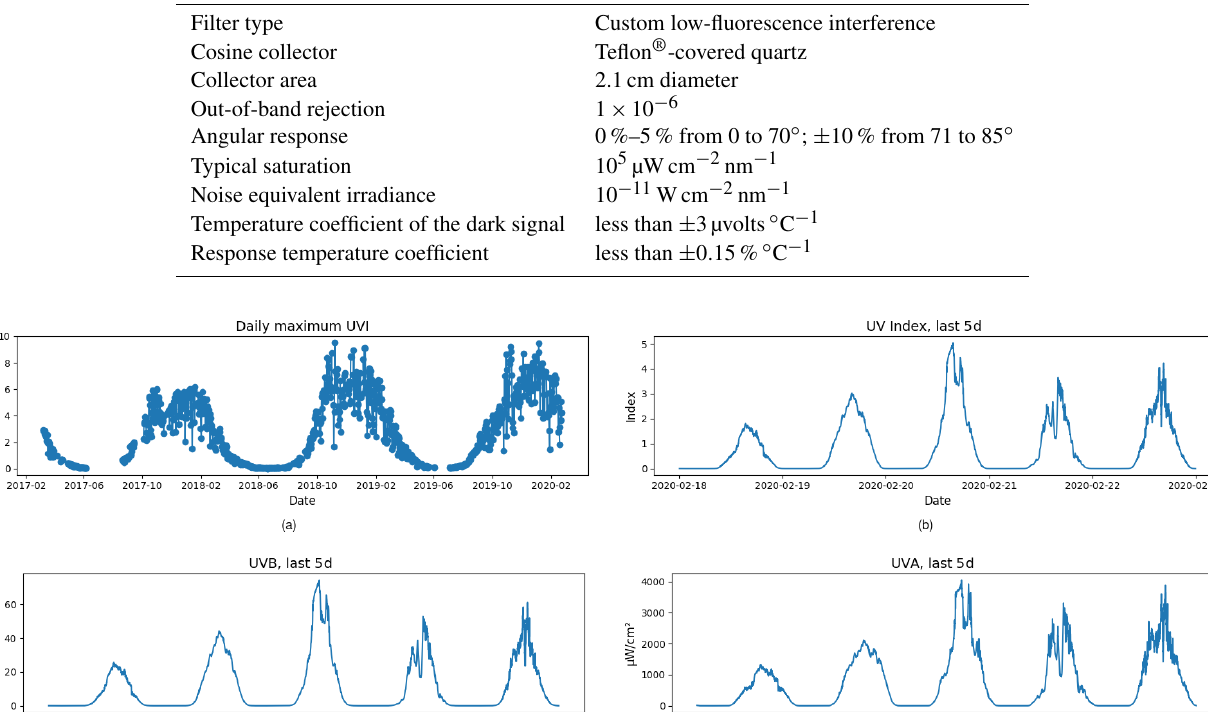
Table 1. GUV model 2511 irradiance array specifications.